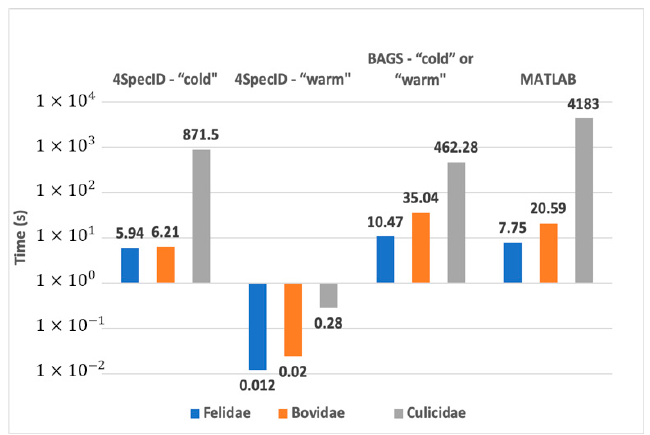
Figure 6. Comparative performance on the laptop: best execution times for a cold and a warm 4SpecID runs compared to BAGS and the original MATLAB